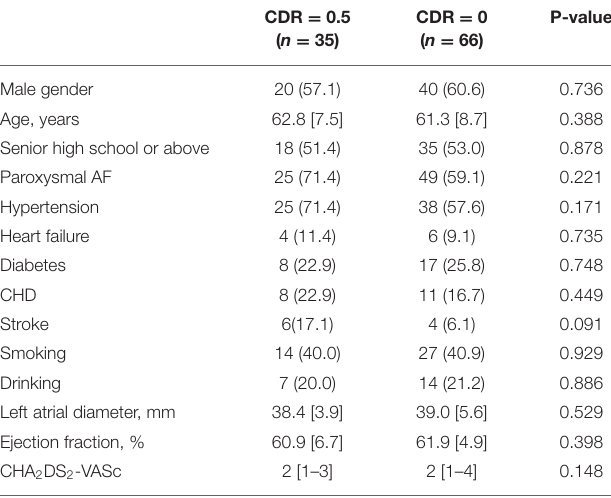
TABLE 1 | Demographics of MCI and cognitively normal